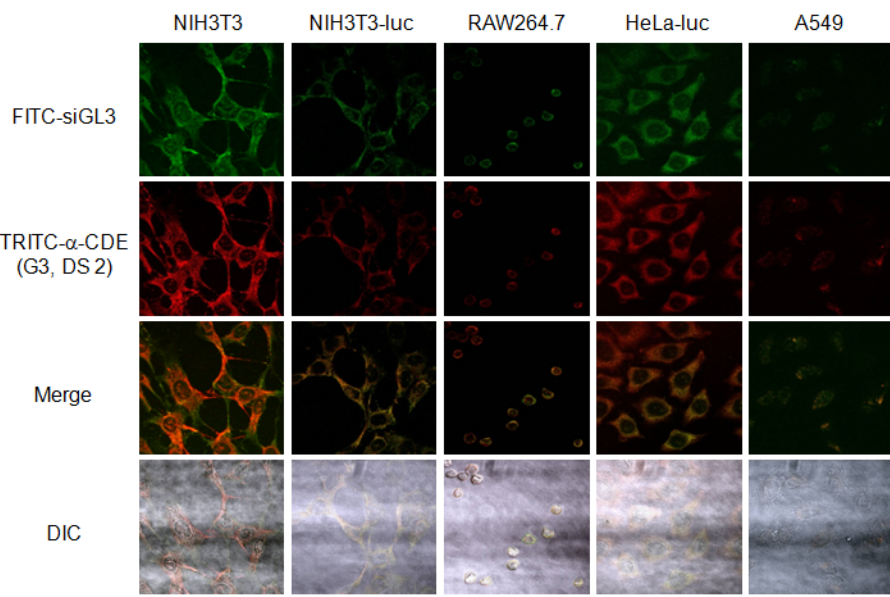
Figure 6. Instracelluar distribution of binary complexes of F1TC-siGL3/TRITC- α -CDE (G3, DS 2) into various